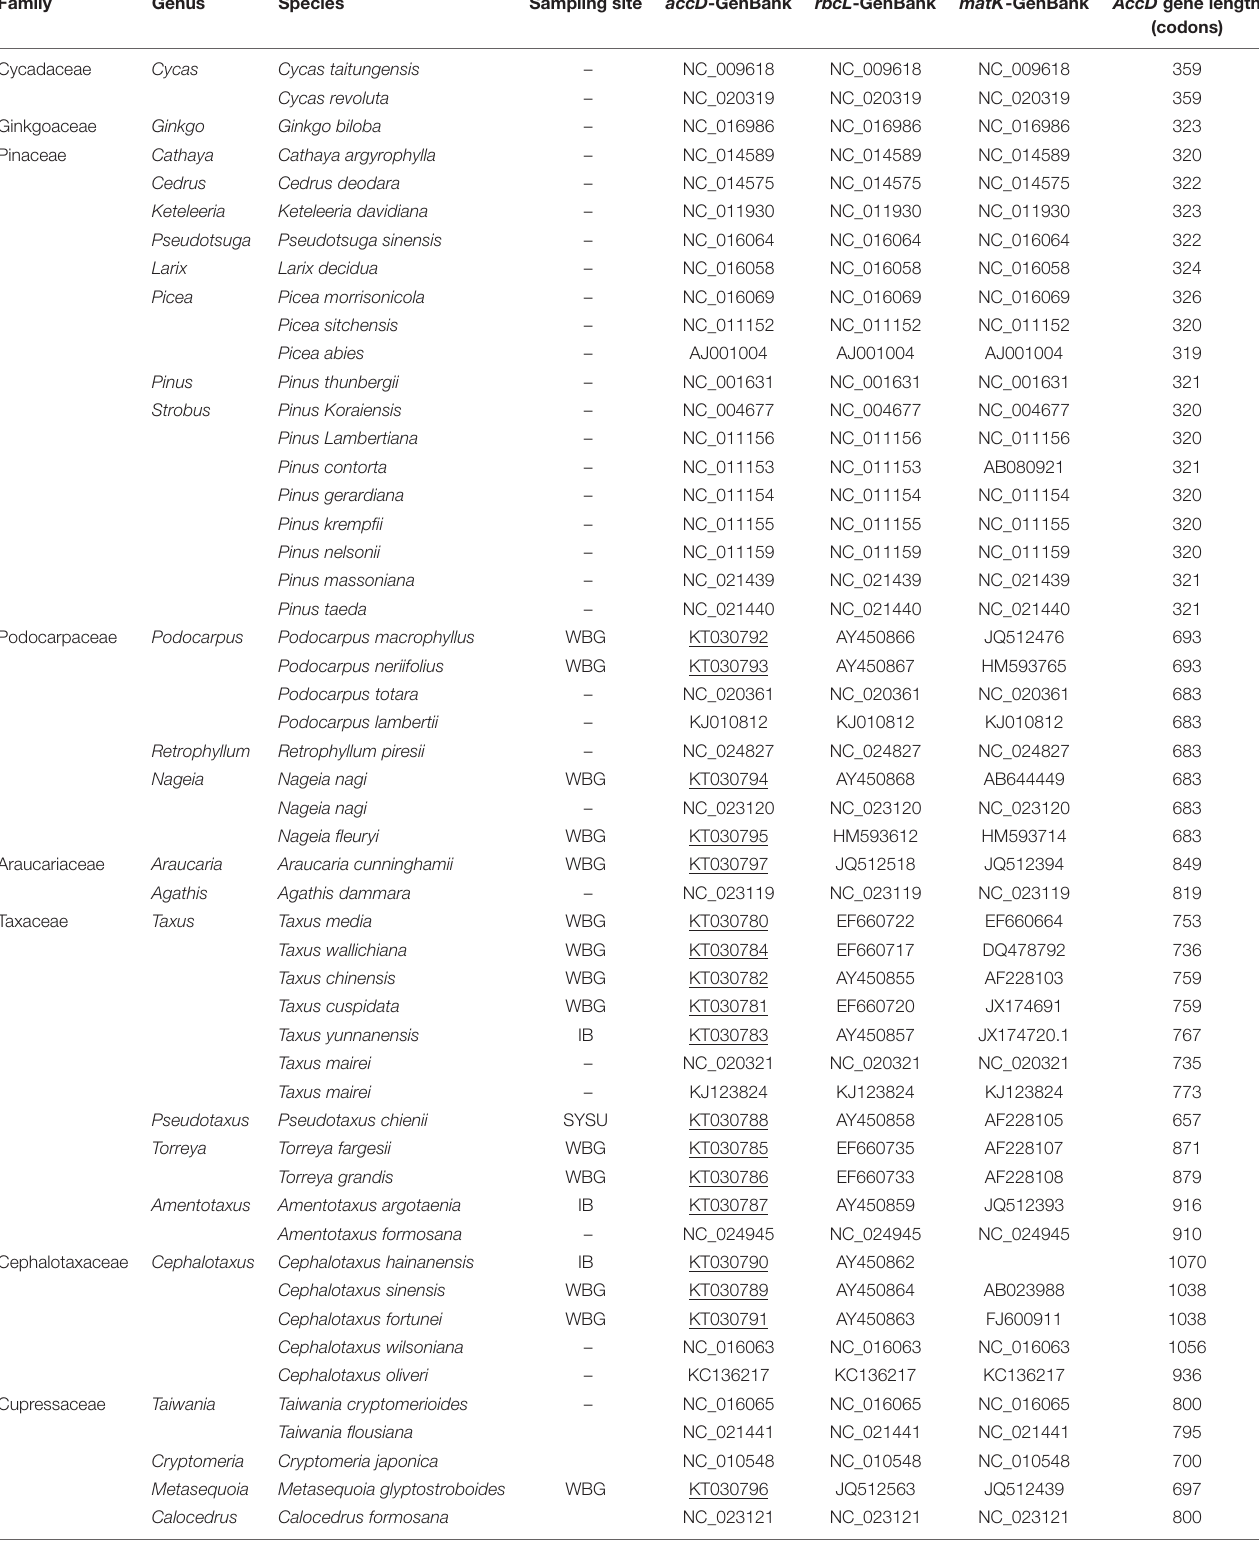
TABLE 1 | List of taxa and sequences analyzed in this study. Family